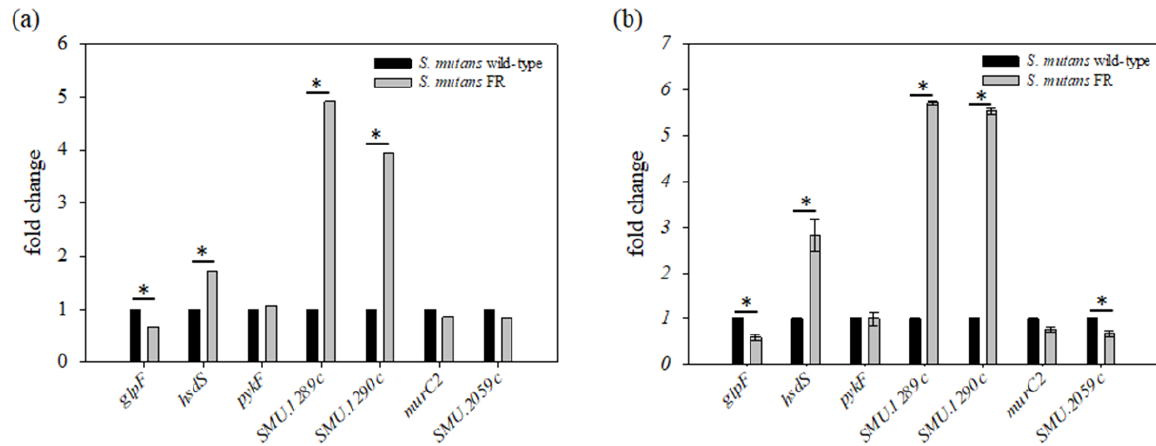
Figure 5. Transcriptional analysis of genes harboring a mutation. ( a ) Transcriptome analysis was performed by RNA-seq technique using total RNA from the wild-type and FR strains, as described in the Materials and Methods. Transcriptome analysis generated a graph that displays the fold-change values of the selected seven genes bearing a mutation in the FR strain compared to that of the wild-type strain; ( b ) Comparison of gene expression between S. mutans wild-type and FR strains measured by qRT-PCR. The wild-type and FR strains were grown to late-exponential phase (OD 600 = 0.6–0.7) in BHI medium at 37 ◦ C in a 5% CO 2 atmosphere. cDNA was synthesized with a random hexamer from 1 µ g of total RNA. The data indicate the fold changes of the target RNA derived from 1 µ g of input RNA after normalization to the 16S rRNA levels in the same samples. * , differs from the wild-type genetic background at p <